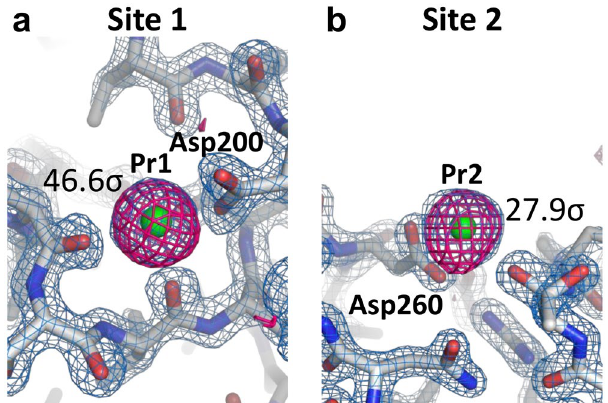
Figure 3. Electron density maps for proteinase K nanocrystals: ( a , b ) close-up views of Pr ion binding sites with 2F o –F c electron density maps contoured at the 2.0 σ level (coloured blue). Bound Pr ions are depicted as green spheres. The anomalous difference Fourier maps using all indexed images (contoured at the 3.5 σ level) are shown in magenta. These figures were drawn with PyMol (http://www.pymol.org).